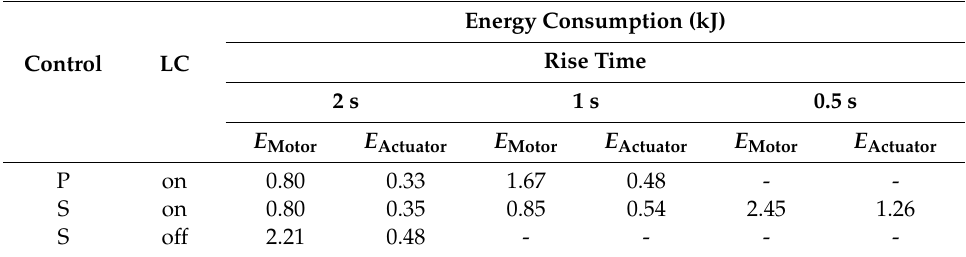
Table 4. Mechanical energy output from the electric motor and hydraulic energy consumption in the actuator cylinder during one lifting–lowering cycle.